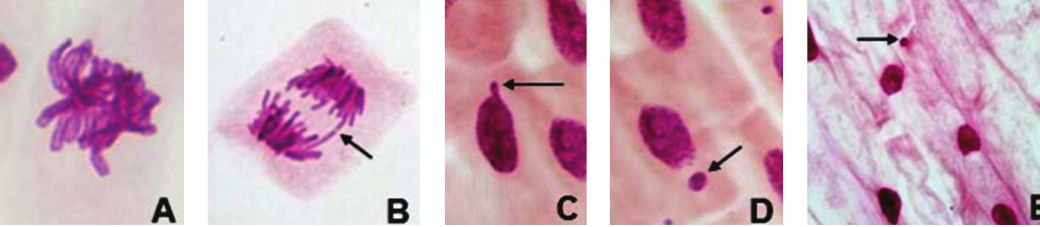
Figure 2: Chromosomal aberrations in Allium cepa exposed to raw biosolid (B) and control soil+biosolid (SB); (A) chromosomal adherence; (B) anaphase with polyploidy and chromosome bridge (arrow); (C) nuclear bud (arrow); (D) meristematic cell carrying micronuclei (arrow); (E) micronuclei in cells of the F 1 region